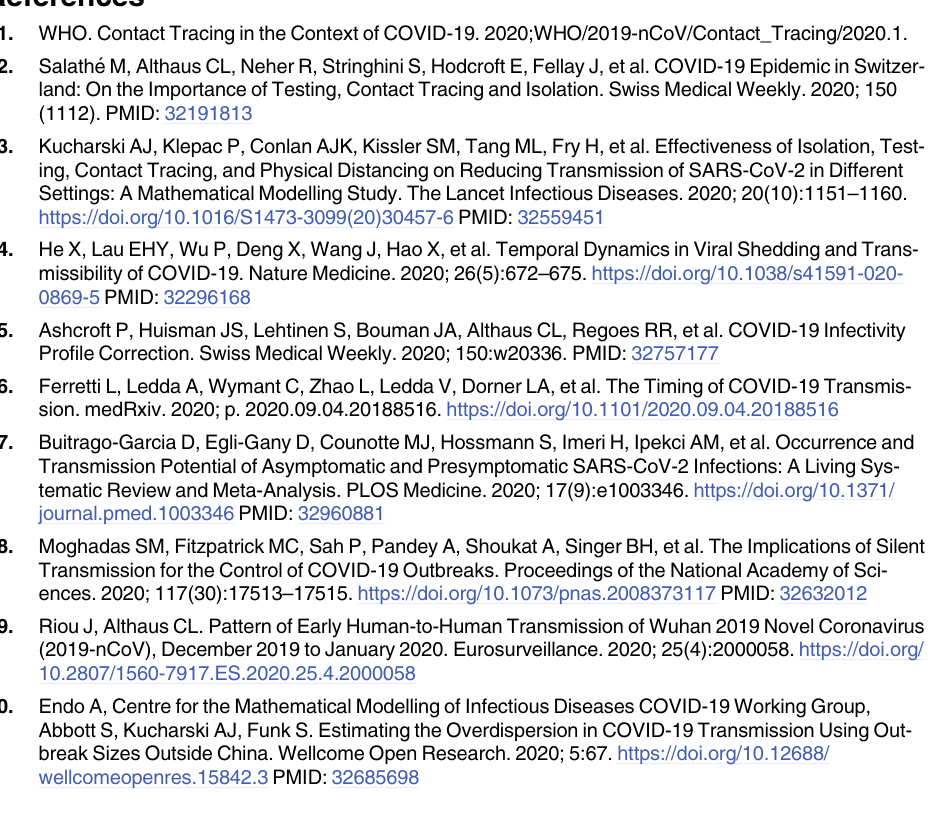
S1 Dataset. Raw data for quantitative